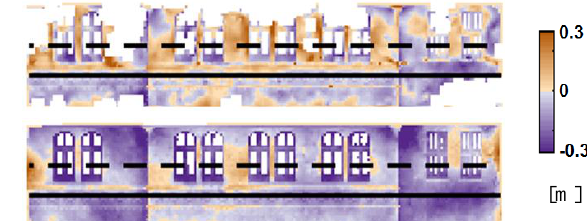
Figure 9. Deviations SURE-TLS (top) and deviations PS-TLS (bottom) of façade 2 Figure 8 and Figure 9 show the results of this process for façade 1 and façade 2, which are highlighted in the TLS reference point cloud depicted in Figure 5. To generate raster